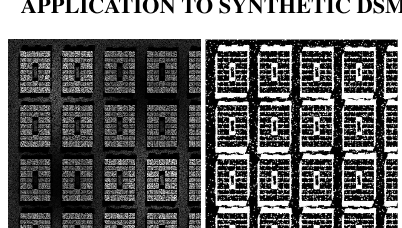
Figure 7: Occluded urban DSM with 40 % holes (left) and hole mask